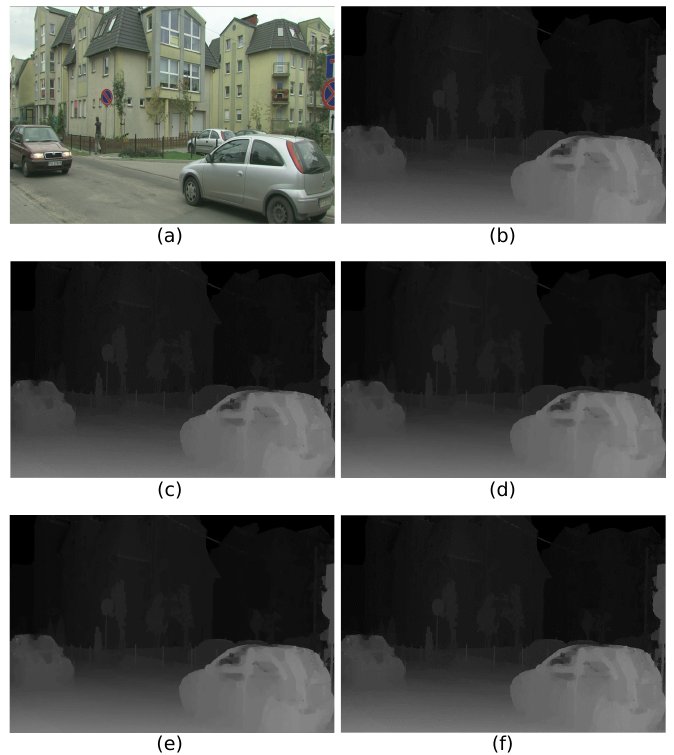
Figure 8. The relationship between BPP and PSNR according to control variable, σ in depth map on